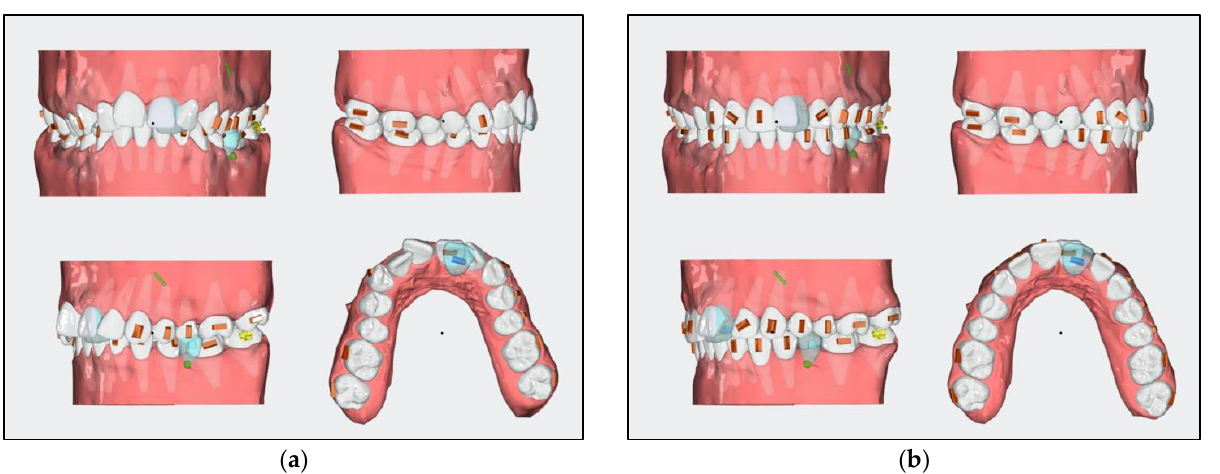
Figure 5. Digital planning: ( a ) pontics of teeth 21 and 35 at the beginning of the orthodontic treatment; ( b ) pontics of teeth 21 and 35 at the end of the orthodontic